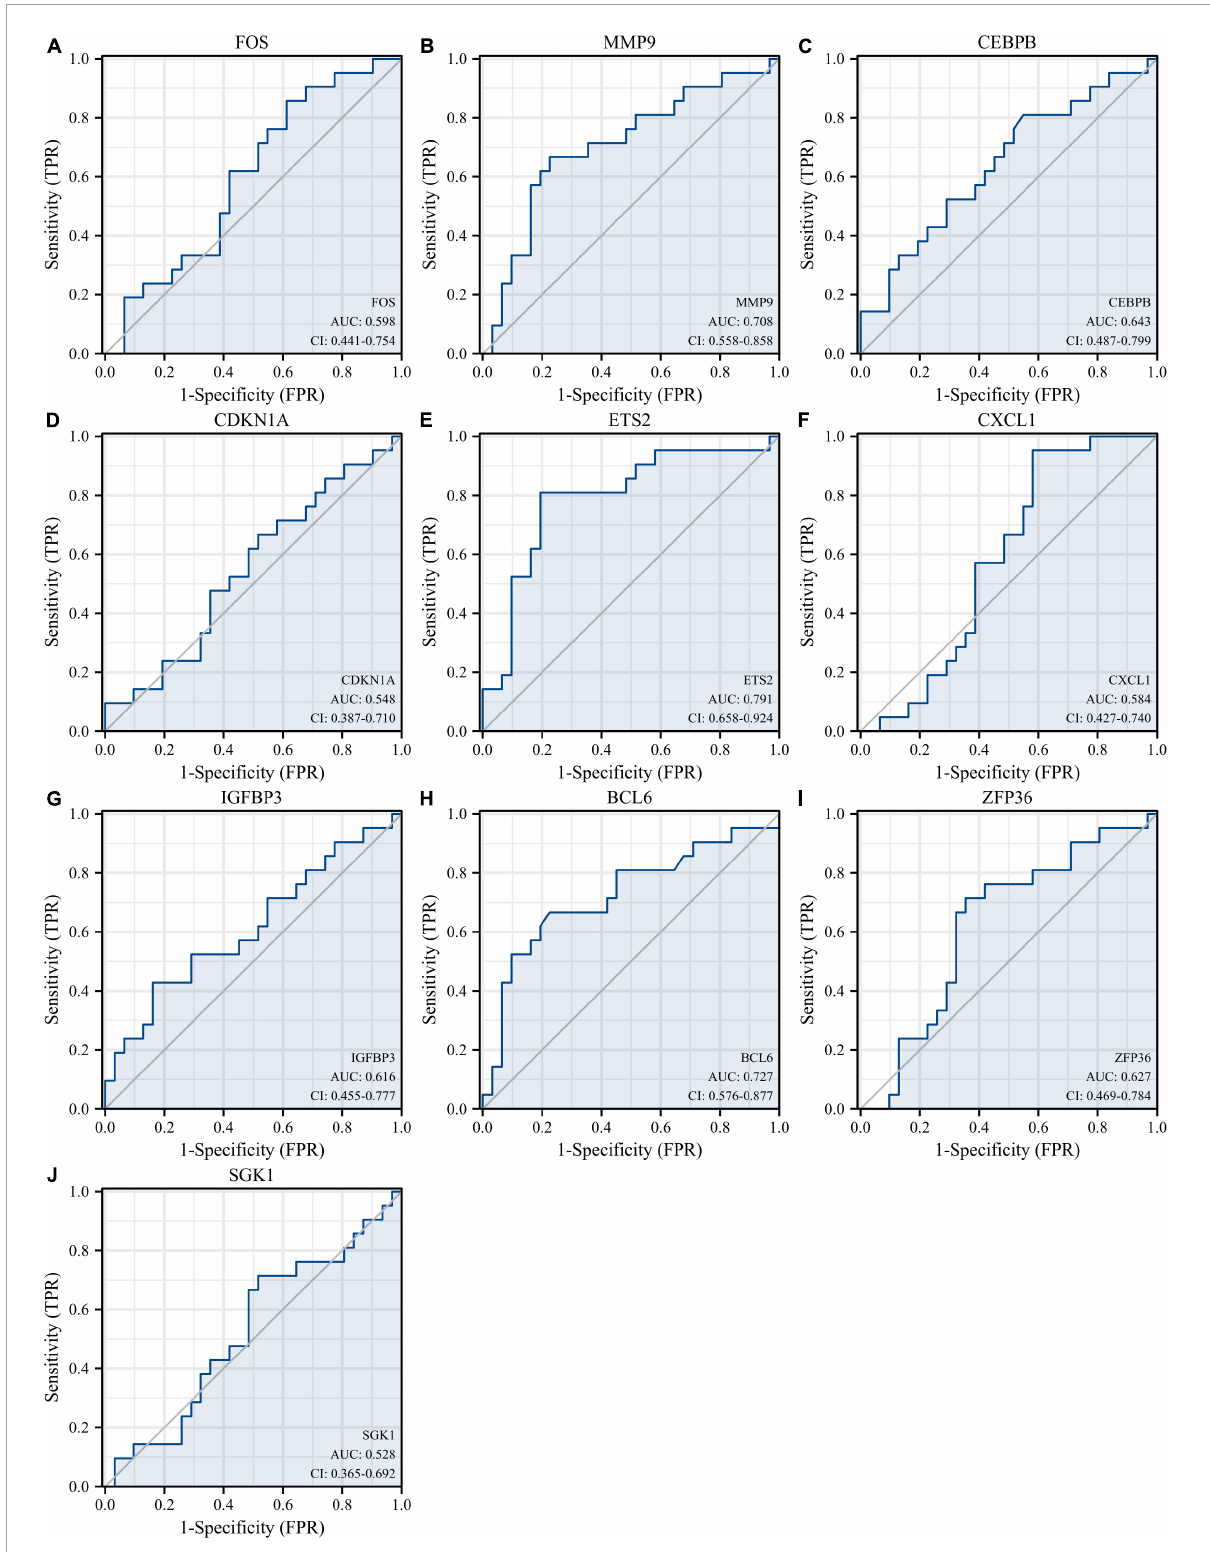
FIGURE12 Diagnostic values of 10 hub genes in the GSE48060 dataset. ROC curves of FOS (A) , MMP9 (B) , CEBPB (C) , CDKN1A (D) , ETS2 (E) , CXCL1 (F) , IGFBP3 (G) , BCL6 (H) , ZFP36 (I) , and SGK1 (J) . ROC, receiver operating